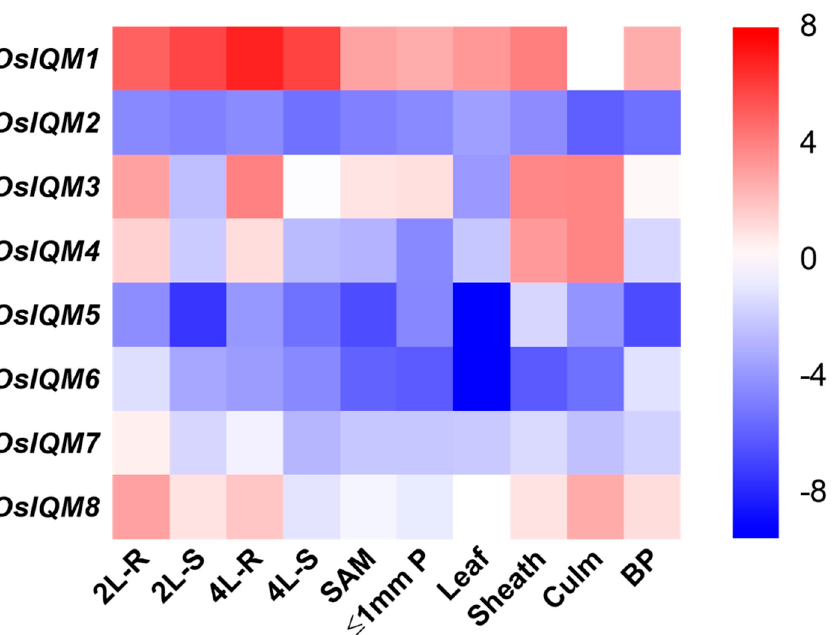
Figure 7. Heat map of the real-time quantitative PCR (qRT-PCR) analysis results of OsIQMs genes across different tissues analyzed, with three biological and technical replicates. The scale representing the relative signal intensity values is shown above. 2L-R—roots of 2-leaf stage seedlings; 2L-S—2-leaf stage seedlings; 10L-SA—shoot apex of 10-leaf stage seedling; ≤ 1P—developing panicles with a length of ≤ 1 cm; BP—booting panicle.